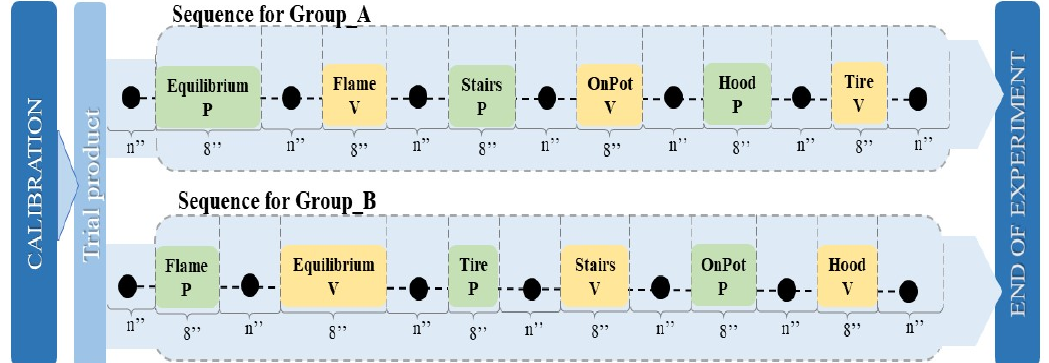
Figure 2. Procedure scheme, where the symbol P (V) means that the product shown is in the form of a picture (video).